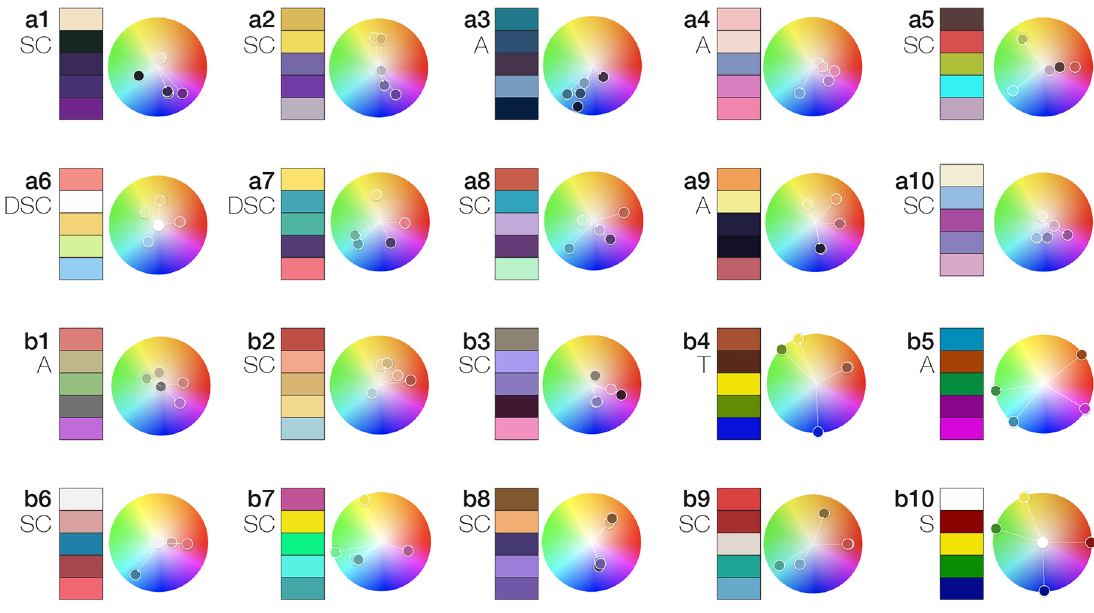
Figure 5: 20 sampled molecular visualization color palettes. (a) 2021 AMI Online Salon color palettes. (b) 2021 VIZBI Protein poster color palettes. Rule abbr: SC, split complementary; DSC, double split complementary; A, analogous; T, triad; S,